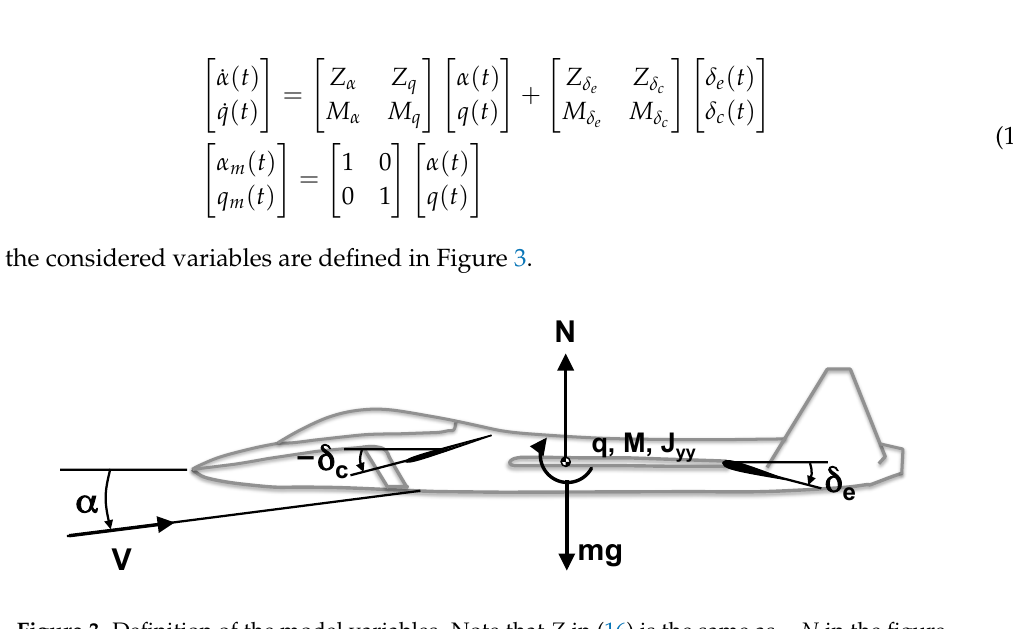
Figure 3. Definition of the model variables. Note that Z in (16) is the same as − N in the figure. (cid:104) The states x ( t ) = α ( t